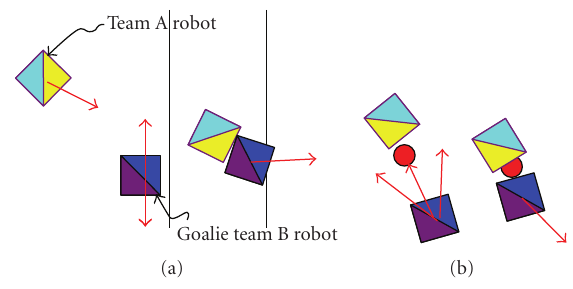
Figure 2: (a) The usual parallel to the goal line movement of a goalkeeper and the perpendicular movement at collision. (b) The expected movement of a robot when the ball is near and the movement at